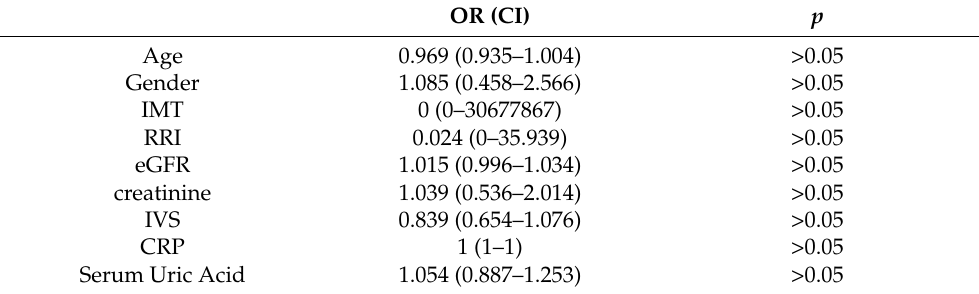
Table 3. Stepwise logistic regression analysis with odds ratio (OR) and 95% confidence interval